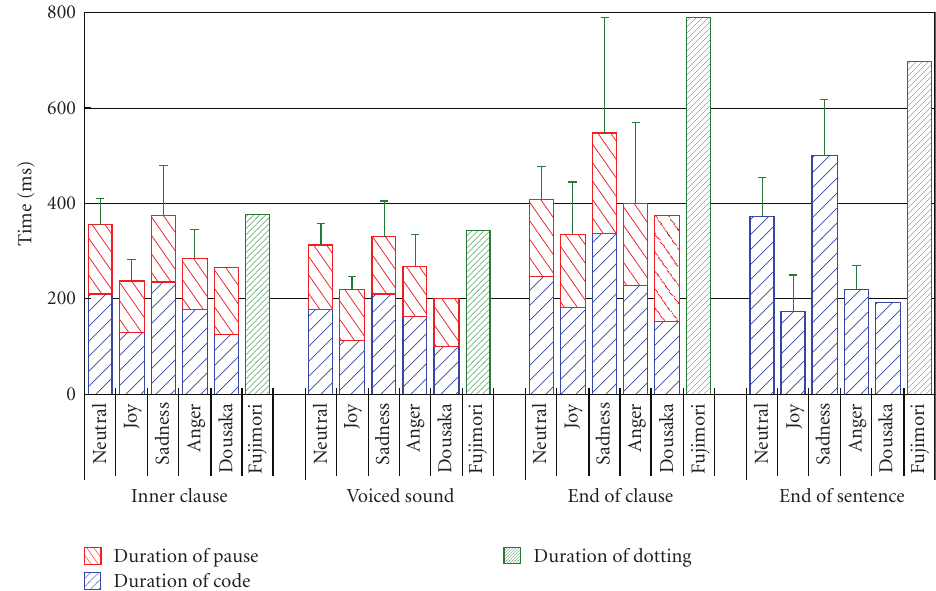
Figure 11: Comparison of durations of code, pause, and dotting between the four emotions in our study and in previous studies [21, 22] for two-handed Finger Braille (error bars represent standard deviations of duration of dotting).